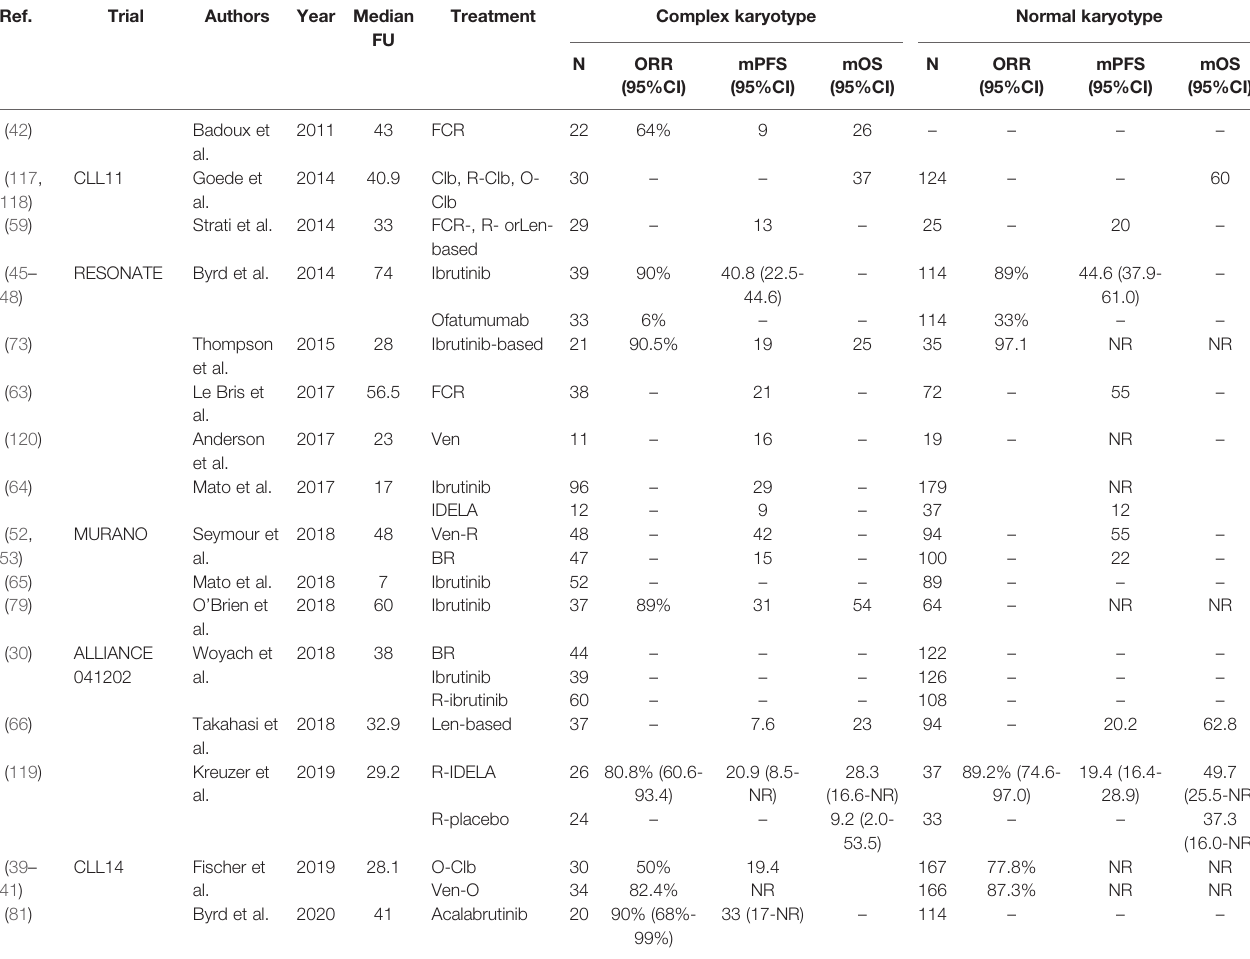
TABLE 5 | An overview of clinical trials comparing treatment regimens for patients with complex karyotype de fi ned as ≥ 3 chromosomal aberrations.